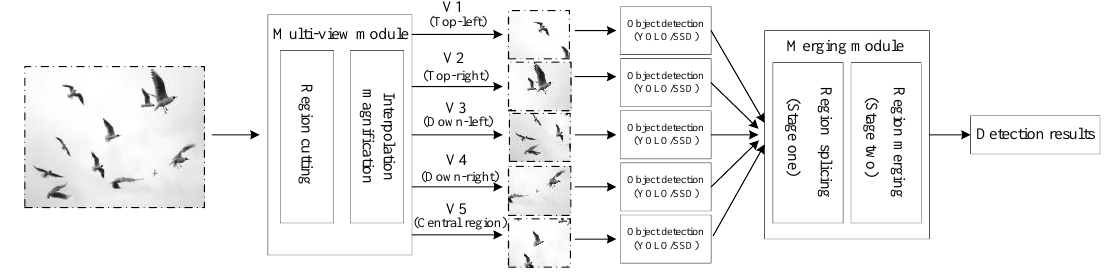
Figure 3. Model for multi-view object detection.